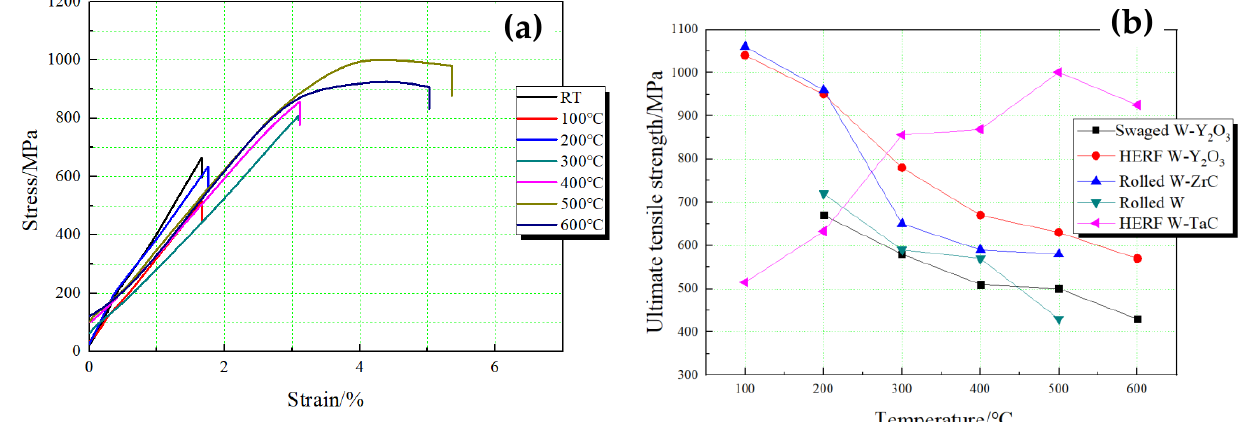
Figure 4. Tensile behaviors of forged WTC alloy ( a ) and the strength of some materials at different temperatures for comparison ( b ). Strength variation of swaged W-Y 2 O 3 [27], HERFed W-Y 2 O 3 [23], rolled W-ZrC [21], rolled W [28], and WTC at different temperatures.